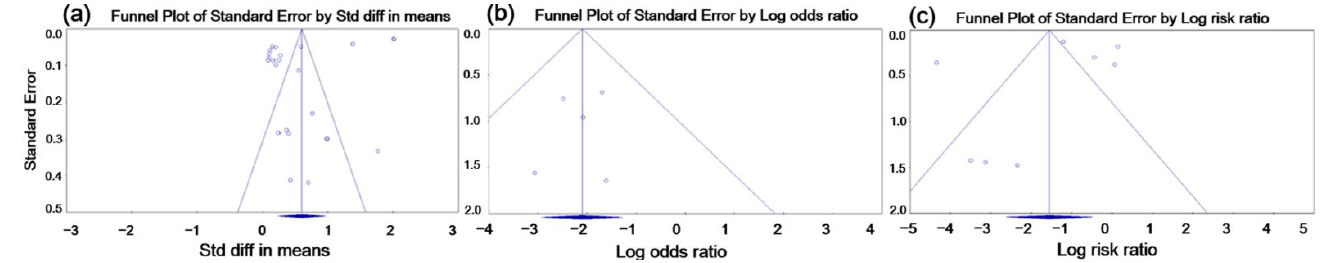
Figure 4. Funnel plots for testing publication bias for the selected trials included in the meta-analysis evaluating the effectiveness of the commercial vaccines against PPE for ADWG (a), fecal shedding rate (b), and mortality rate (c). The funnel plot shows the standard error of each trial on the vertical axis (precision) and the effect size of each study (a, SMD; b, pooled OR; c, pooled RR) on the horizontal axis to investigate the magnitude of asymmetry showing publication bias.